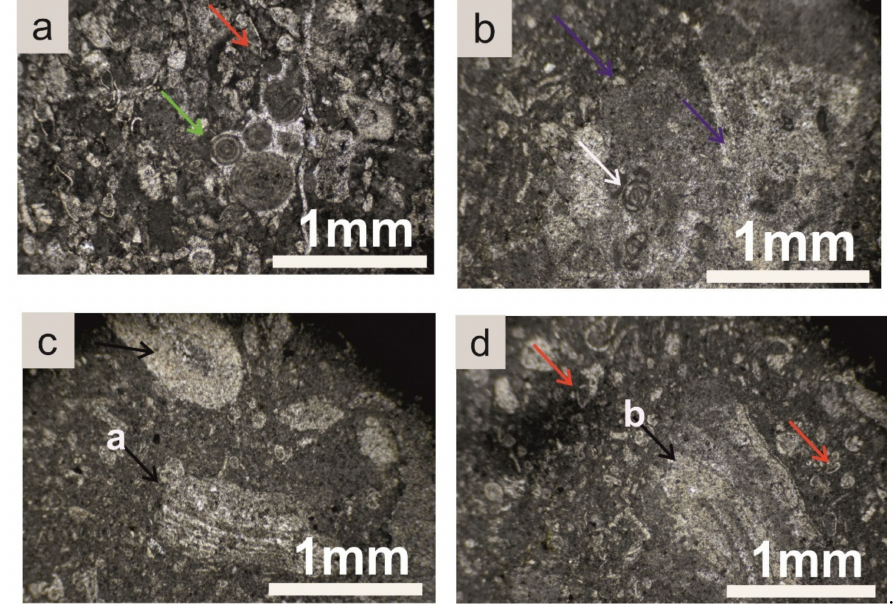
Figure 13. Microfacies type F1: Allochthonous, bioclastic-lithoclastic packstone/floatstone microbrec- cia of Paleocene age. ( a ) planktic foraminifera (red arrow), oolitic grainstone green arrow), sample KM15, ( b ) grainstone with benthic foraminifera (purple arrow), Miliolidae (white arrow), sample KM15, ( c ), Bioclasts (Mollusk?. black arrow), sample KM16, ( d ) Bioclasts (black arrow), sample K1, ( a ) ooids (green arrow), ( d ) planktic foraminifera (red arrow), planktic foraminifera (red arrow), sample